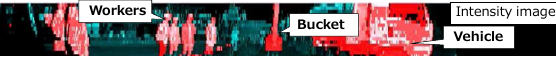
Figure 14. Intensity image and extracted moving objects